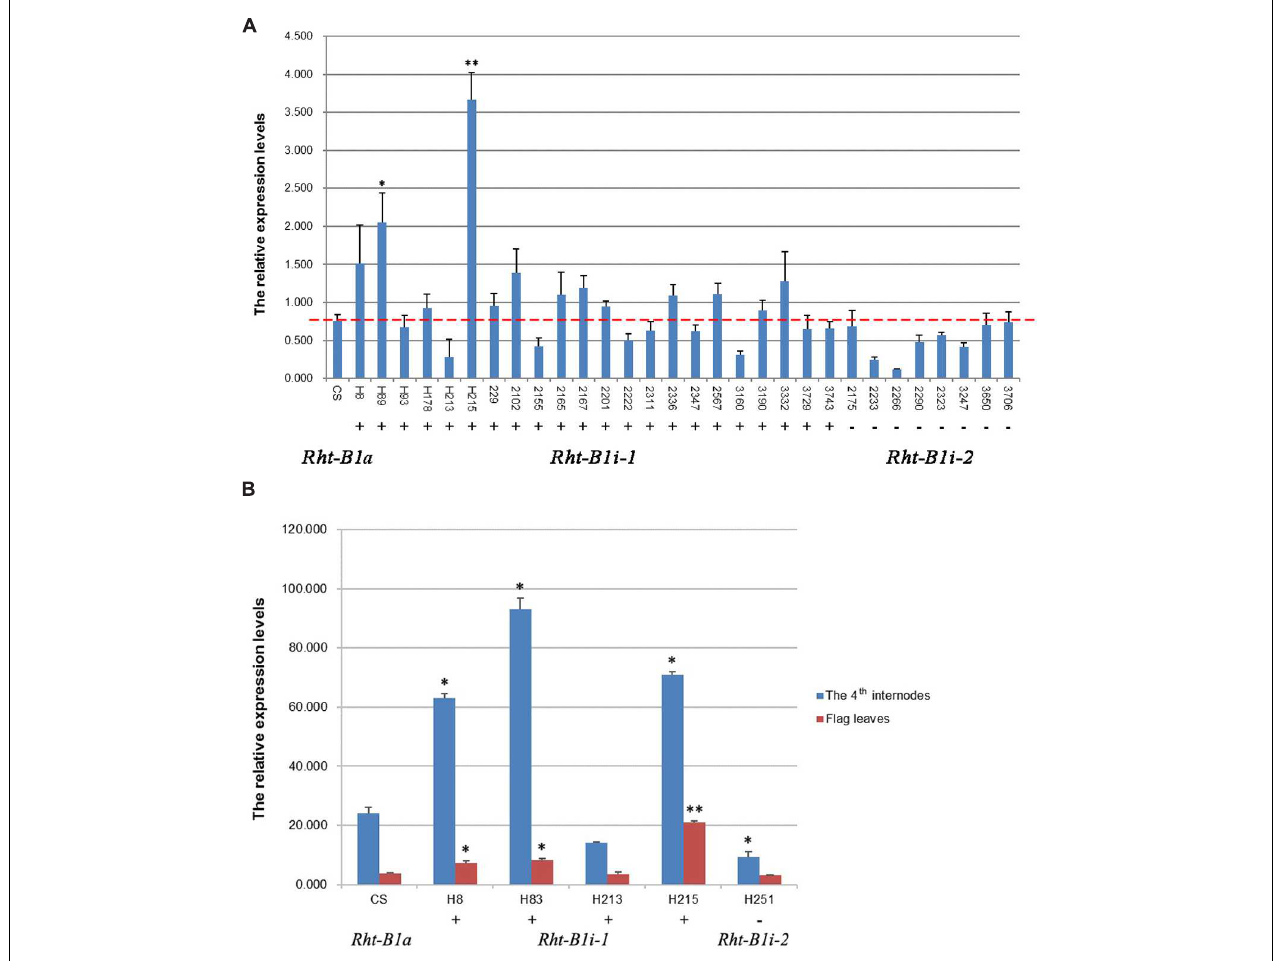
FIGURE 4 | Expression analysis of Rht-B1i-1 and Rht-B1i-2. (A) Expression analysis in seedlings, (B) Expression analysis in flag leaves and the fourth internodes. The red line shown the relative expression levels of Rht-B1 in CS which containing Rht-B1a (control). ∗ , ∗∗ Denotes significant differences at 5 and 1% probability levels, respectively. + , – Denote Rht-B1i-1 containing the 160 bp insertion and Rht-B1i-2 missing the 160 bp insertion, respectively.